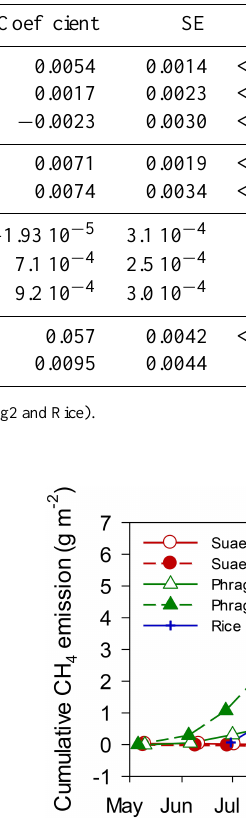
Figure 2. Cumulative CH 4 emissions during the growing season 2012 from two Suaeda salsa wetlands, two Phragmites australis wetlands and one rice paddy during 2012 in the Liaohe Delta, Northeast China. The points represent integrals of the monthly mean values from six plots at each site. Measurements are missing from Phrag1 in August due to